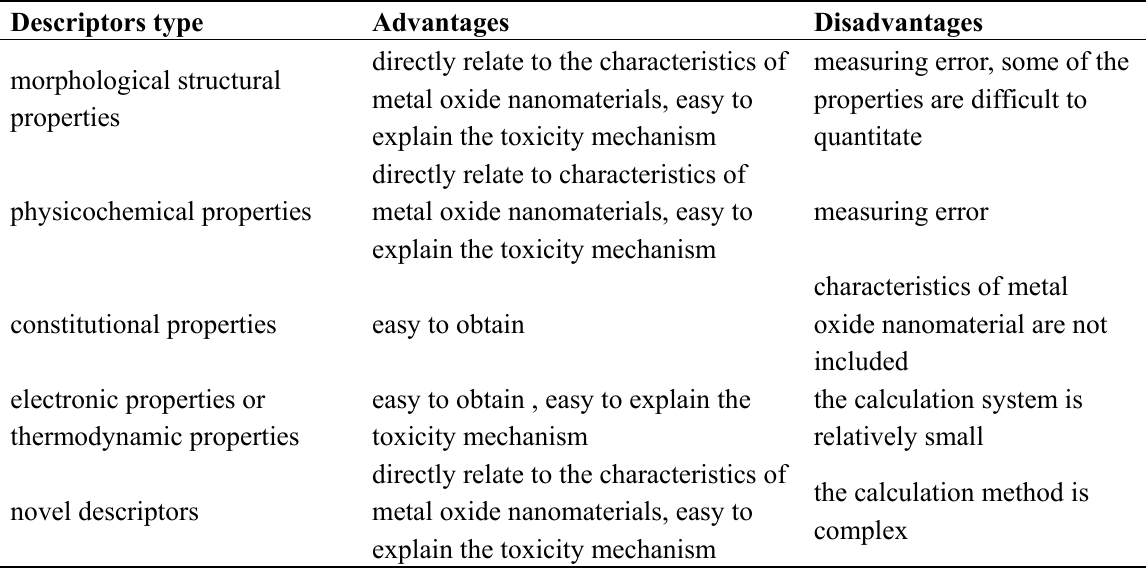
Table 4. Advantages and disadvantages of different structural descriptor types in metal oxide QNAR